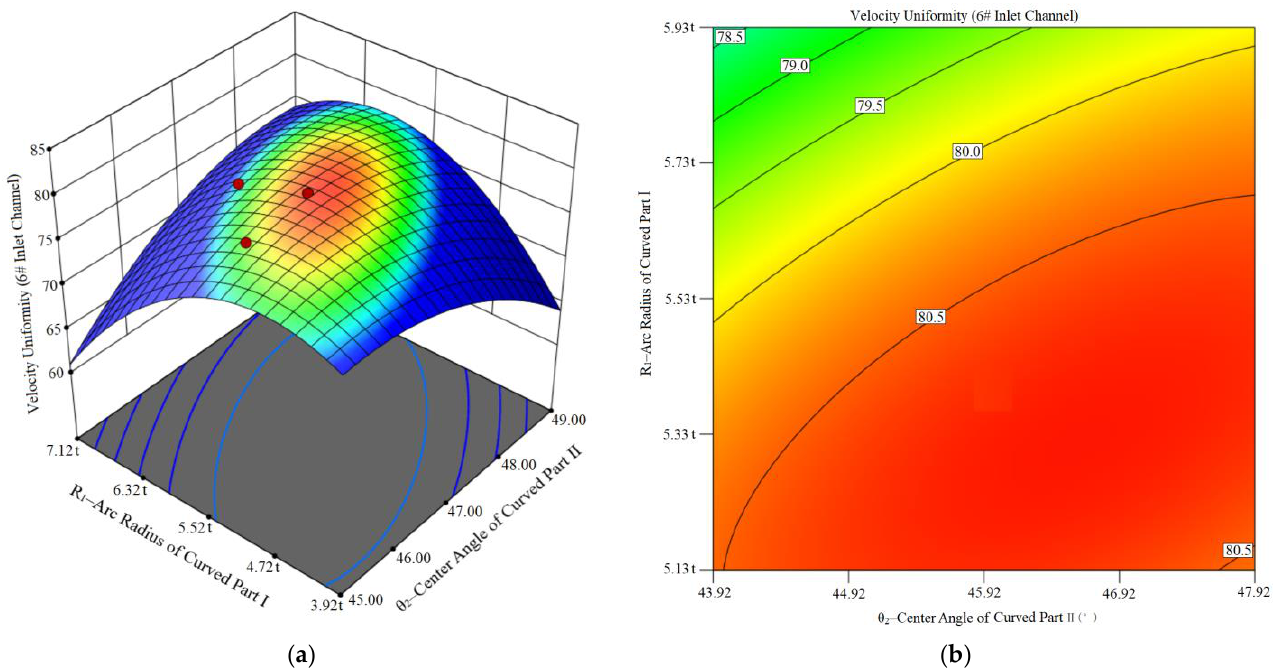
Figure 11. Three-dimensional effect diagram and contour map (operational state of pumping): ( a ) three-dimensional effect diagram; ( b ) three-dimensional contour map.